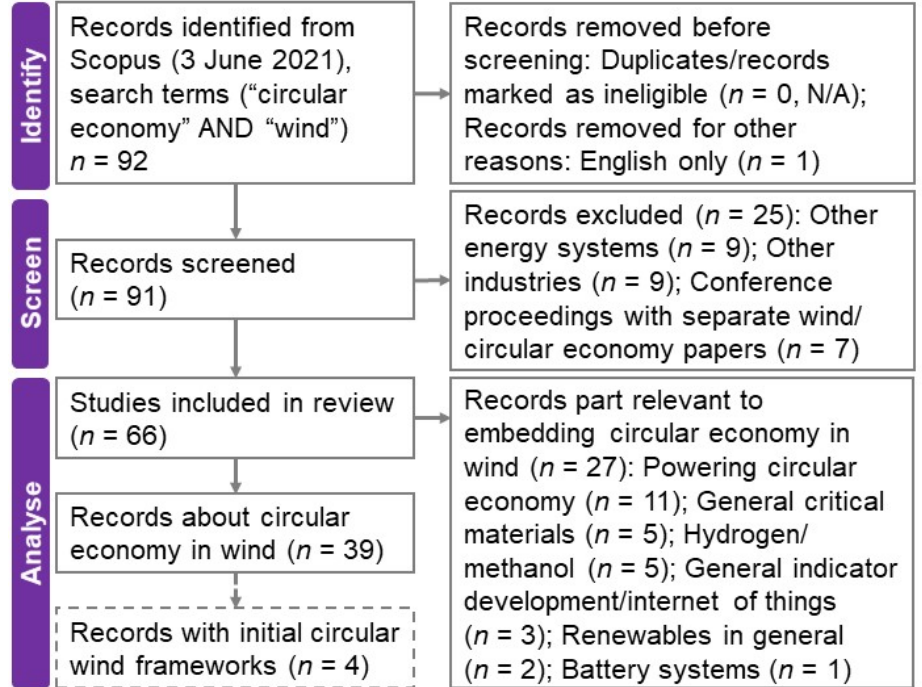
Figure 1. Systematic review of scientific publications on circular economy and wind energy based on the PRISMA guidelines [121] .